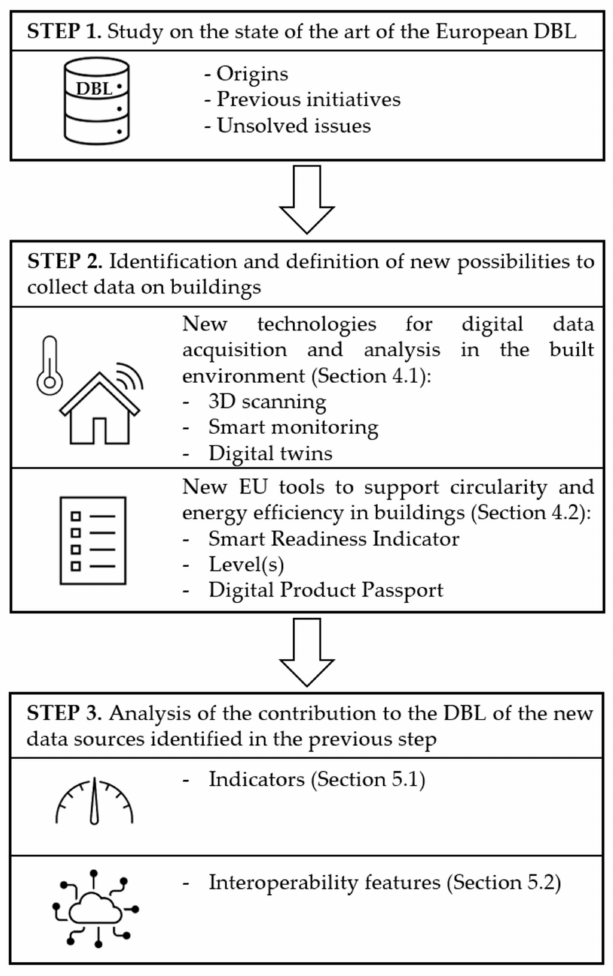
Figure 1. Steps undertaken for the research